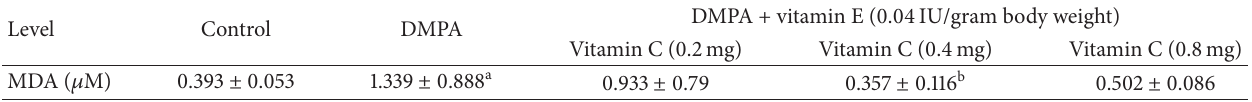
Table 2: Levels of ovarian malondialdehyde in each experimental